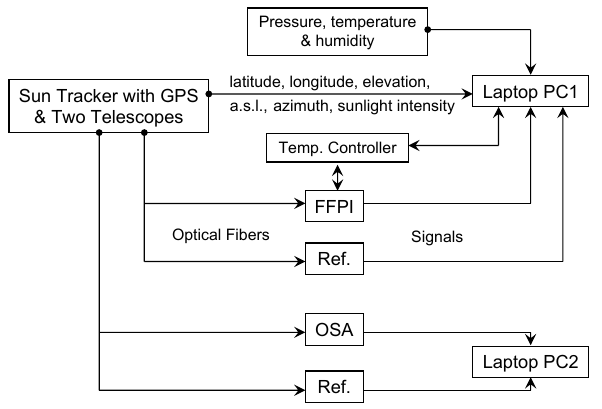
Fig. 1. Block diagram for data acquisition. Fig. 2 Fig. 2. CO 2 photoabsorption spectra measured by OSA and FTS on 26 August 2009 at Moshiri in Hokkaido,